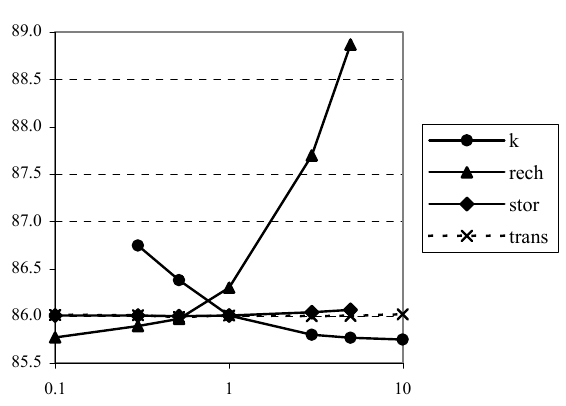
Fig. 5. Variability of water level, m a.s.l. (observation point No. 4 in Figs 4, 8) after eight years of exploitation of the dolomite quarry versus the ratio of parameter value to calibrated value (hydraulic conductivity ( k ), recharge (rech), storativity (stor) and transfer rate (trans)). cannot significantly affect the results of modelling. The largest variability is determined for the recharge (the difference between the upper and lower bounds for the water level in the observation point No. 4 is 3.1 m) and for hydraulic conductivity (difference 1.0 m). Thus, the parameters of recharge and especially hydraulic conductivity are noticeably critical and can affect the results and must be correctly selected during calibration of the model.